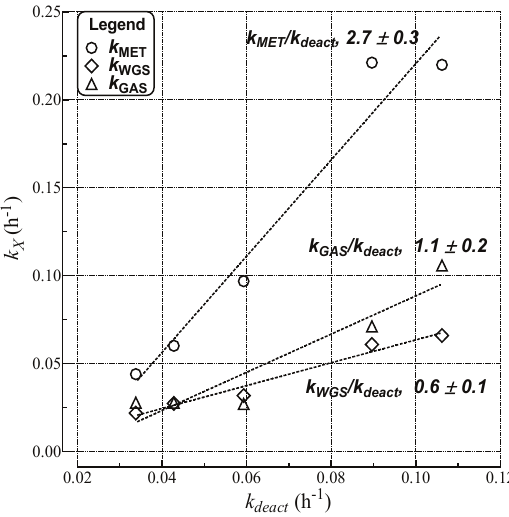
Figure 9. Relationships between k (adapted from ref. [15] with the kind permission of Wiley, copyright